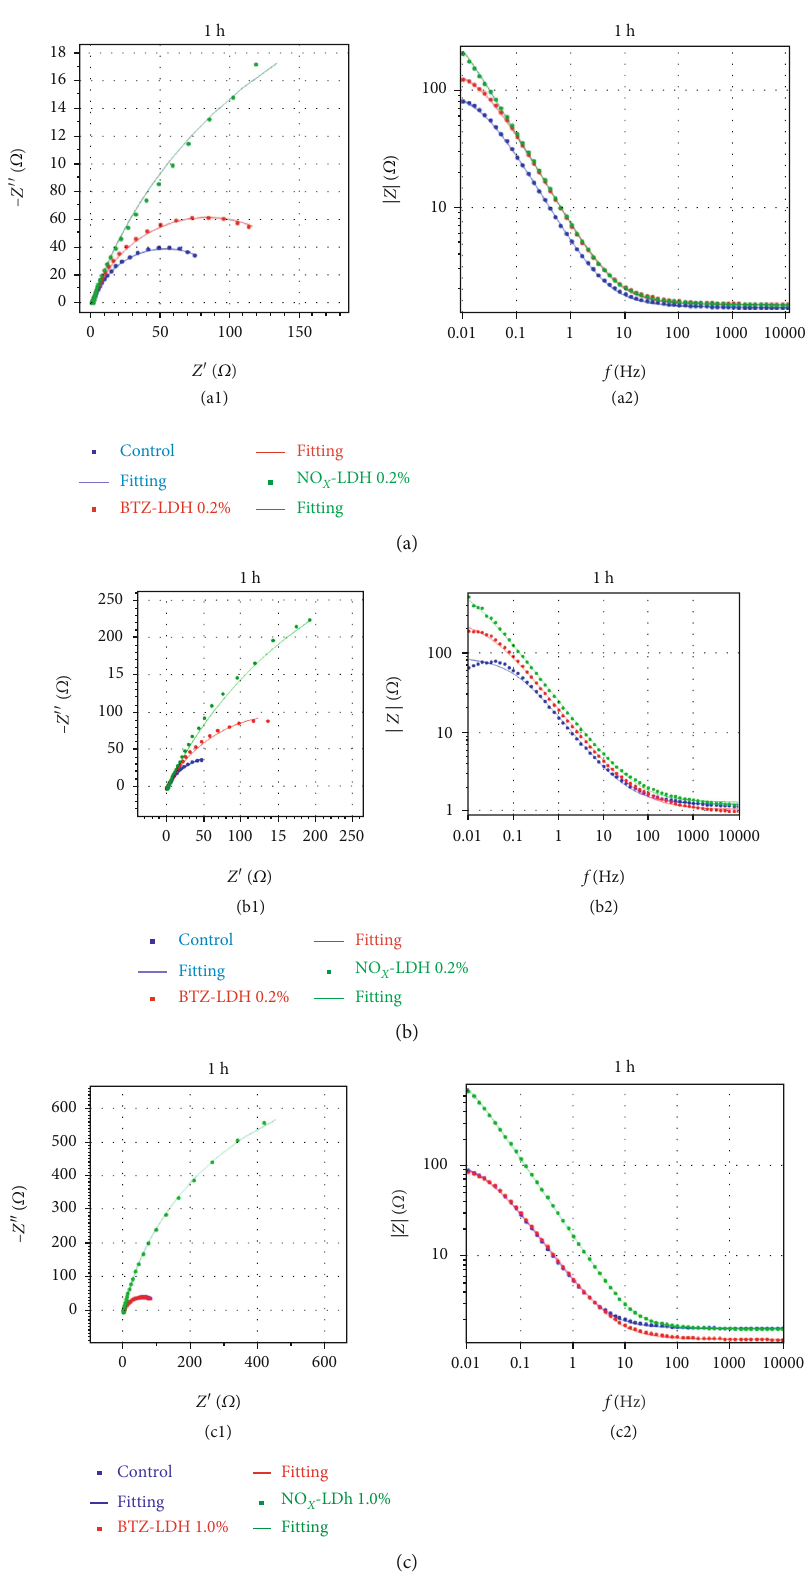
Figure 12: Nyquist plots (1) and Bode modulus plots (2) obtained for systems containing (a) 0.2%, (b) 1.0%, and (c) 3.0% extracts after 1h of immersion (exposed area: 17cm 2